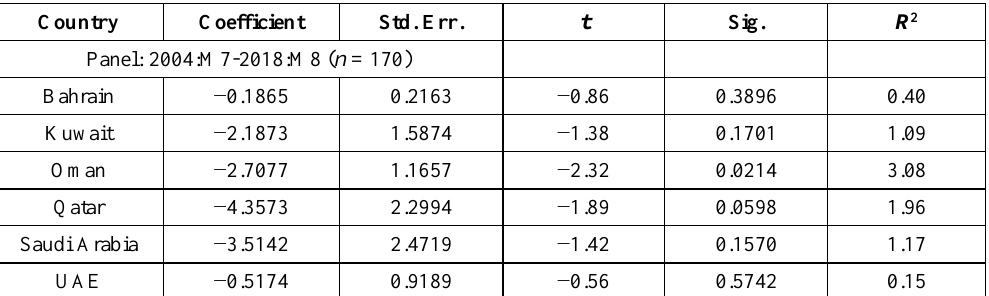
Table 3 . Regression results of the impact of the economic policy uncertainty in the U.S. on the monthly returns of each GCC country